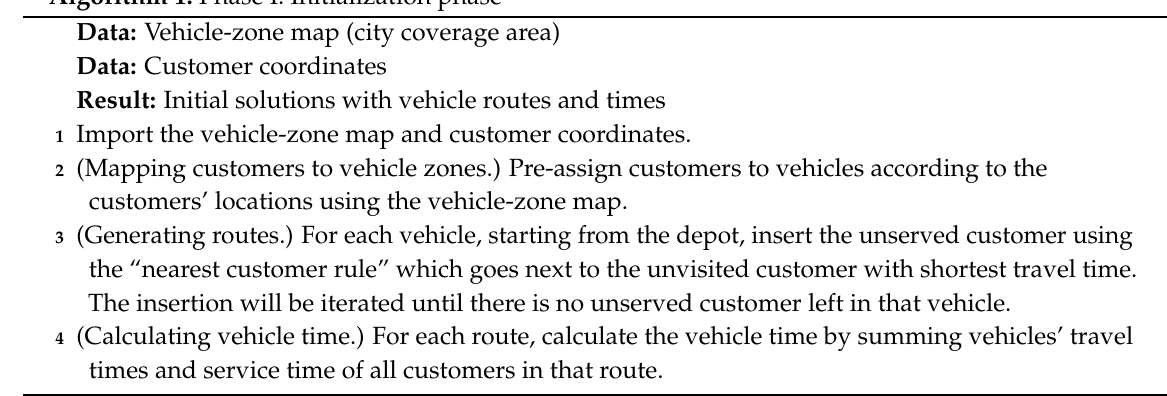
Algorithm 1: Phase I: Initialization phase Data: Vehicle-zone map (city coverage